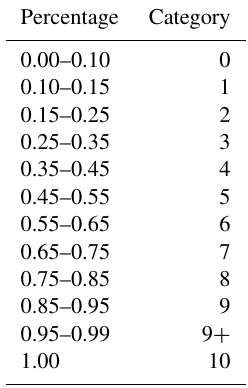
Table 1. Conversion of C to concentration categories C t found in ice